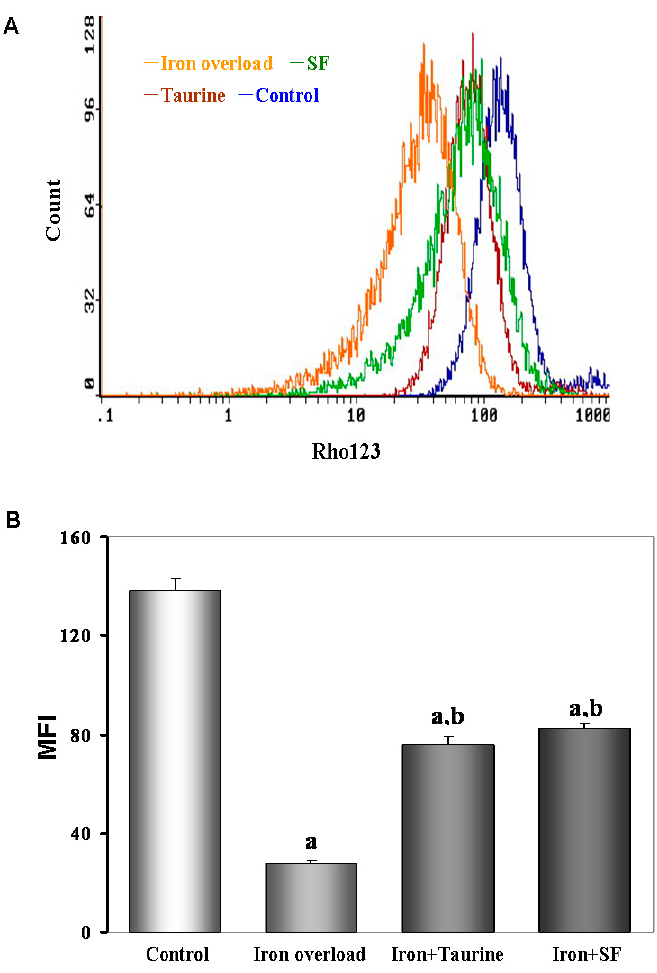
Figure 6. The effects of TAU or SF on mitochondrial membrane potential (MMP) in iron-overloaded mice. ( A ) Fluorescent indicator Rhodamine123 was used to detect the change of MMP in different gourps. The fluorescent distribution curve shifted to the left in iron overload group, indicating a reduction of MMP. However, the curve shifted to the right in the cells treated with ST or TAU; ( B ) Quantitative analysis of mean fluorescence intensity (MFI) of Rhodamine123. Data represents mean ± SE of 12 independent experiments. a: p < 0.01, vs. control group; b: p < 0.01, vs. iron overload group.